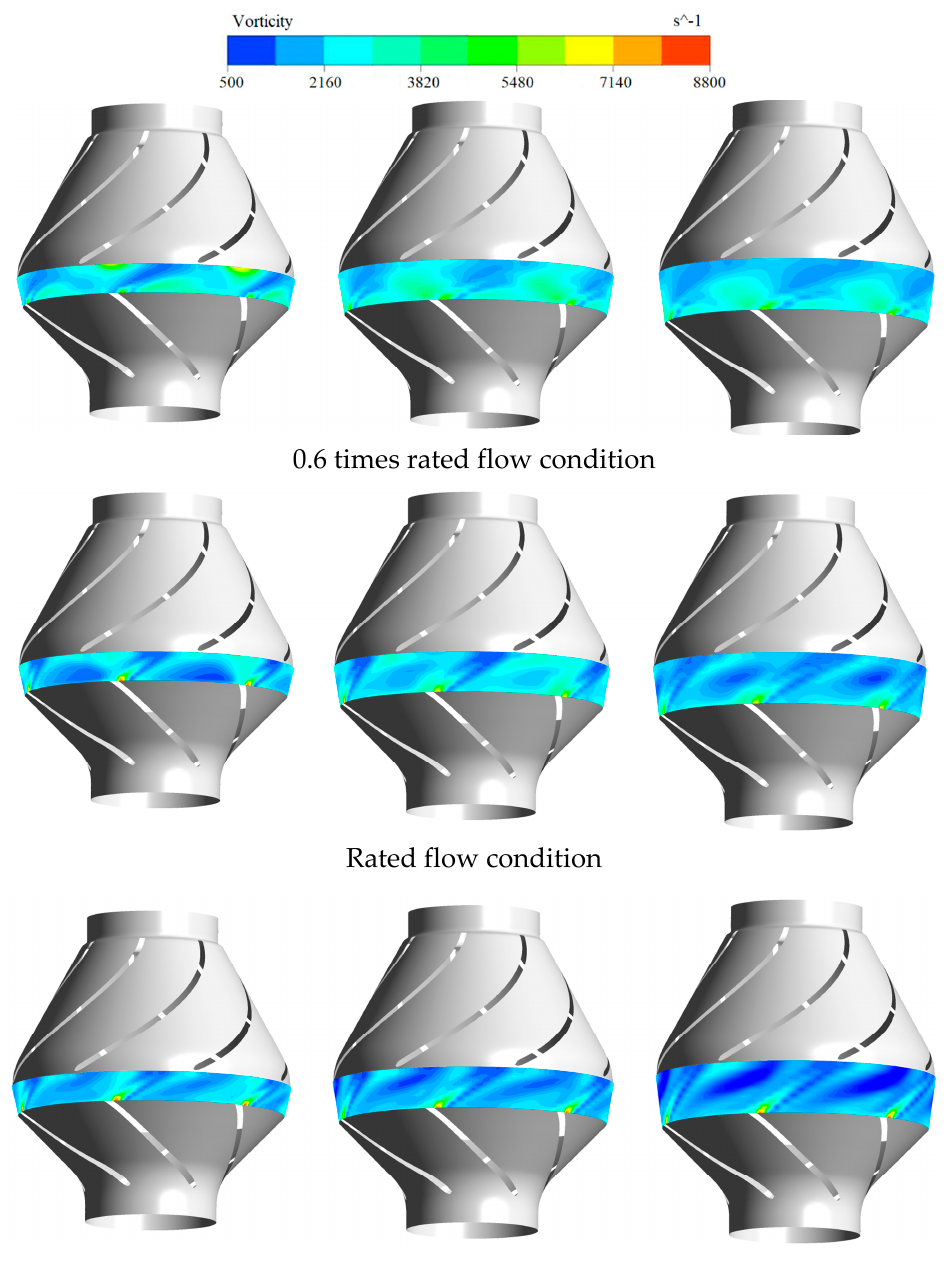
Figure 10. Vorticity distribution at mid-span position within the chamber: rotor–stator distance = 1.5 mm; rotor–stator distance = 4.5 mm; rotor–stator distance = 7.5 mm.